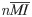
Distributions of the values of nMI¯ for various domain pairings.A: Distribution of the values (N = 5, 205) of nMI¯ for domain pairs in native (non-disrupted) multi-domain protein sequences. B: Distribution of the values (N = 5, 205) of nMI¯ for domain pairs after intra-architectural domain sequence shuffling. C: Distribution of differences (N = 5, 205) between the values of nMI¯ for individual domain pairs before and after intra-architectural domain sequence shuffling. D: Distribution of the values (N = 2, 599) of nMI¯ for domain–random sequence pairs.